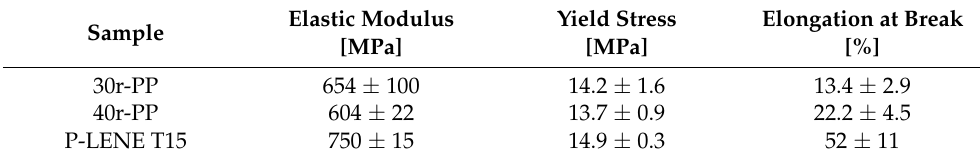
Figure 6. Stress-strain curves for 30r-PP and 40r-PP FFF-printed samples. Table 5. Main mechanical properties for 30r-PP, 40r-PP, and a commercial PP sample.